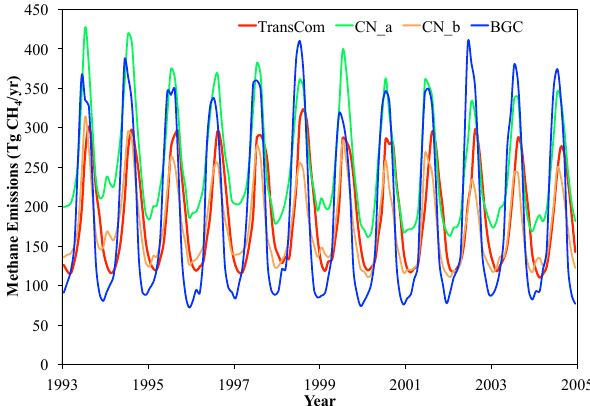
Figure 1. Comparison of the time series of combined methane emis- sions from wetlands and rice paddies used in the TransCom (Patra et al., 2011), CN_a, CN_b, and BGC experiments. Note that the av- erage methane budget over the period of 1993–2004 is the same in the TransCom, CN_a, CN_b, and BGC experiments. CN_b is the reduced CN_a.